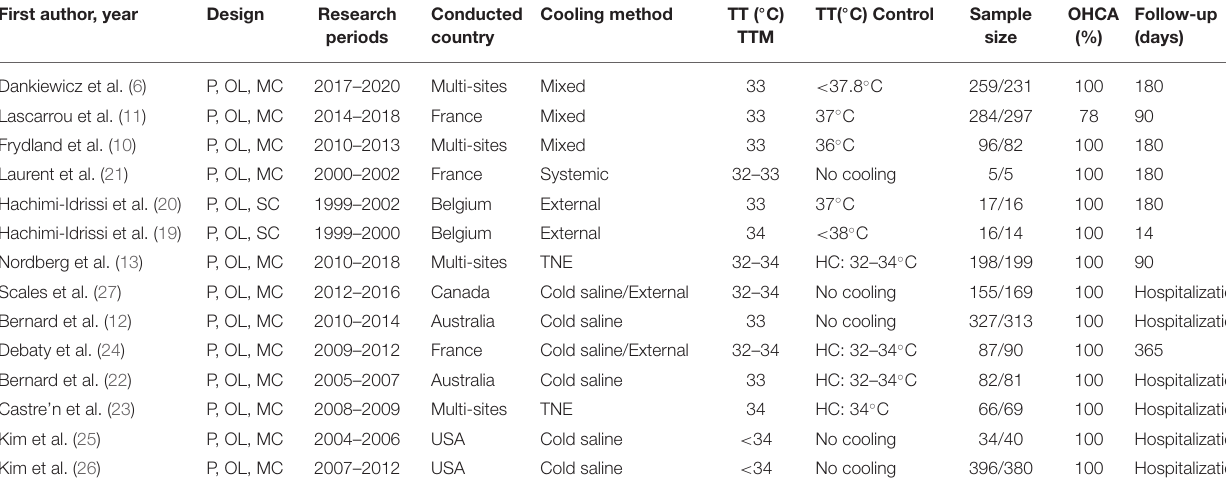
TABLE 1 | Characteristics of the studies included in current systemic review and meta-analysis.